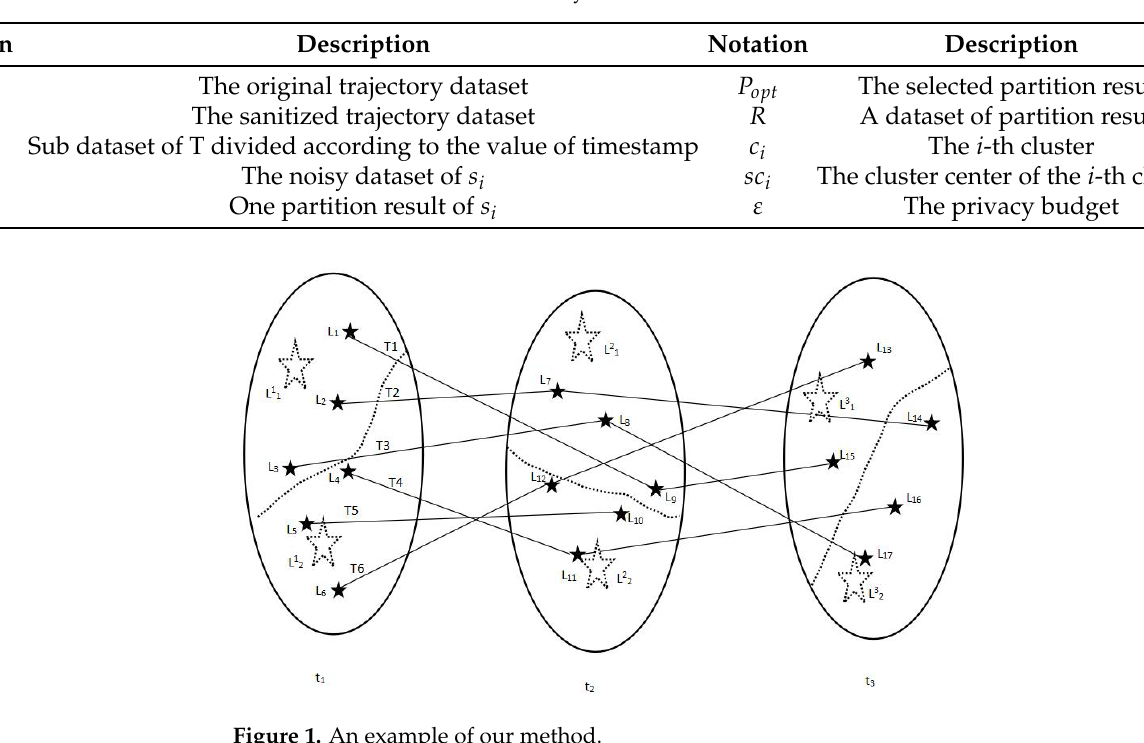
Table 3. Summary of notations.